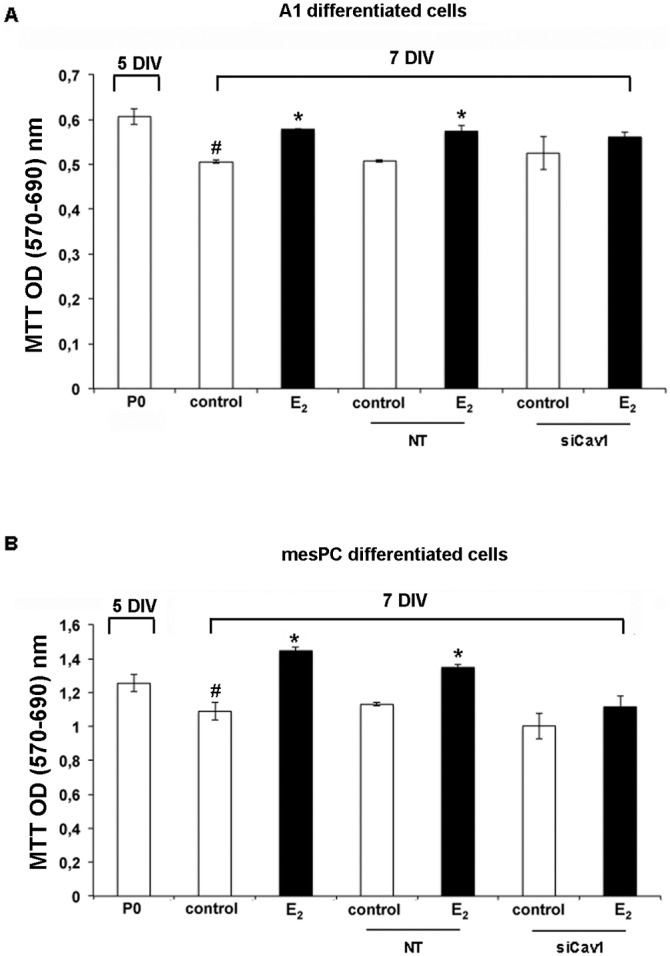
E2–dependent survival is affected by Cav1 downregulation.The diagrams show the E2 effect, assessed by MTT assay, in non-proliferating A1 (A) and mesPC (B) cells after transfection of non-targeting, NT, or Cav1 siRNA construct (siCav). P0 indicates the start point of E2 stimulation (5DIV). Asterisks represent p<0.01 when compared to control cultures treated with vehicle (ANOVA, Scheffè F-test). The hash sign represents p<0.05 between control cultures at 7DIV compared to control cultures at 5DIV (ANOVA, Scheffè F-test).